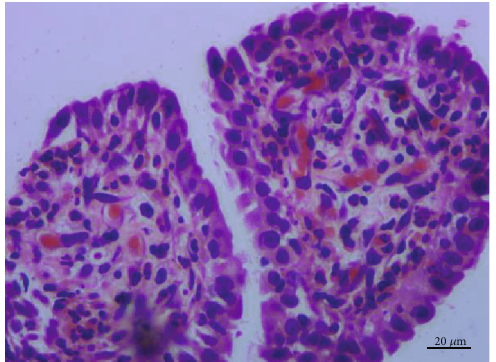
Figure 13: Ki67 index was about 5%, ×